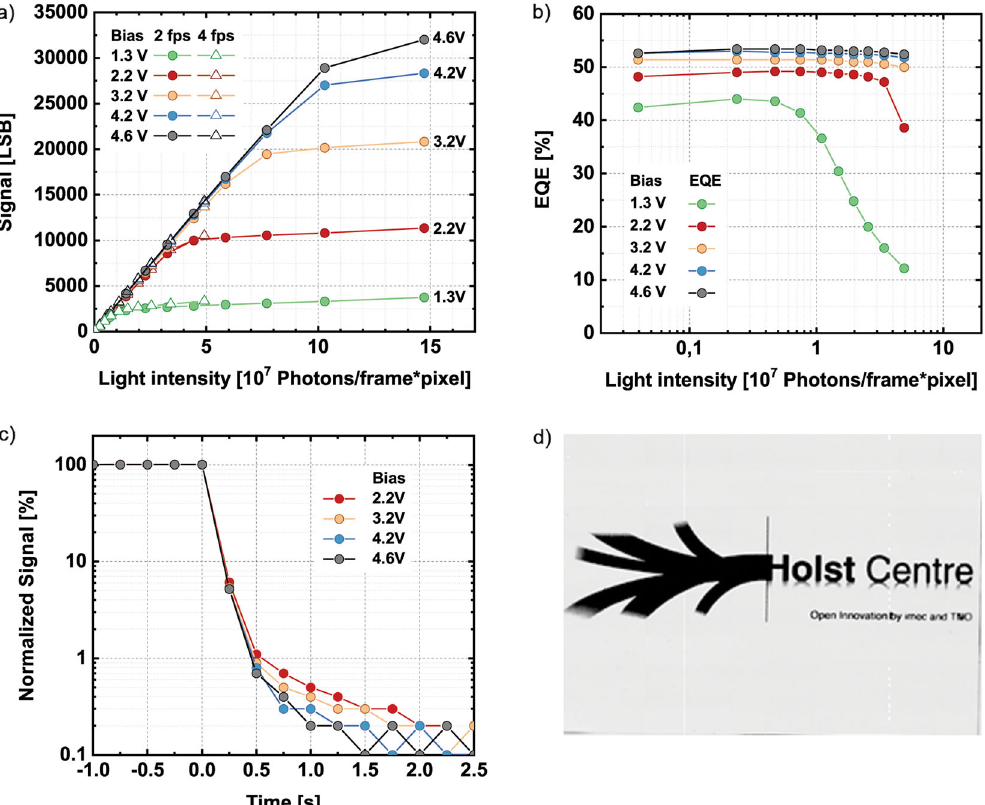
Fig. 4 Optical array characteristics. a Light signal in least signi fi cant bits (LSB, ADC digital output) vs. impinging light intensity. Photons per frame and pixel are varied via length of the light pulse and calculated from the measured light power per cm 2 . The applied photodiode bias voltage was varied. The measurement was done for 2 frames per second (fps), equivalent to 500 ms integration time and 4 fps, equivalent to 250 ms integration time. A log – log plot of ( a ) is shown in Supplementary Fig. 5. b EQE as calculated from the slope of the graphs from ( a ) vs. impinging light intensity. c Temporal behavior of the image sensor. At t = 0 the light pulse is switched off, and the decay of photocurrent is monitored for different applied biases. d Optical image taken with the image sensor on